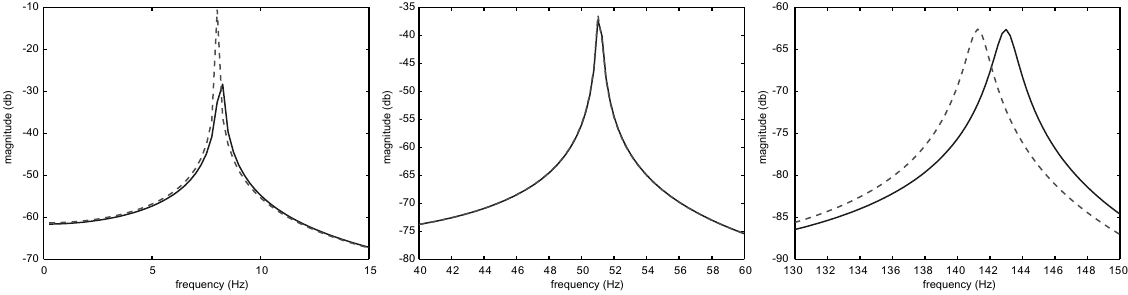
Fig. 4. Zoom on response functions of point 7 around resonance frequencies for undamaged (full line) and damaged (dashed line) case. In both the undamaged and the damaged case two different loading conditions are considered. The first loading condition k consists of a unit harmonic point force, F k , applied in the vertical direction in location 1. The second loading condition l is a unit harmonic point force, F l , applied in location 3 (Fig. 1). Both experiments are